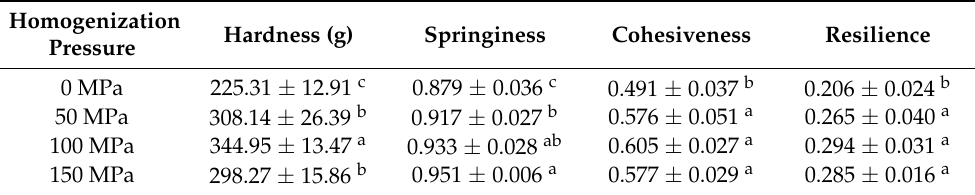
Table 2. The hardness, springiness, cohesiveness, and resilience of pork myofibrillar protein with high-pressure homogenization-modified soy 11S